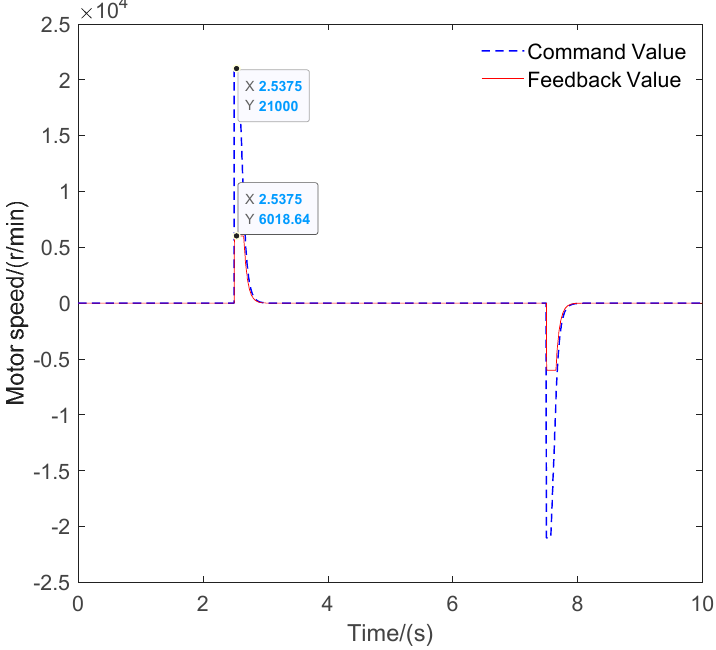
q d axis current, axis current,